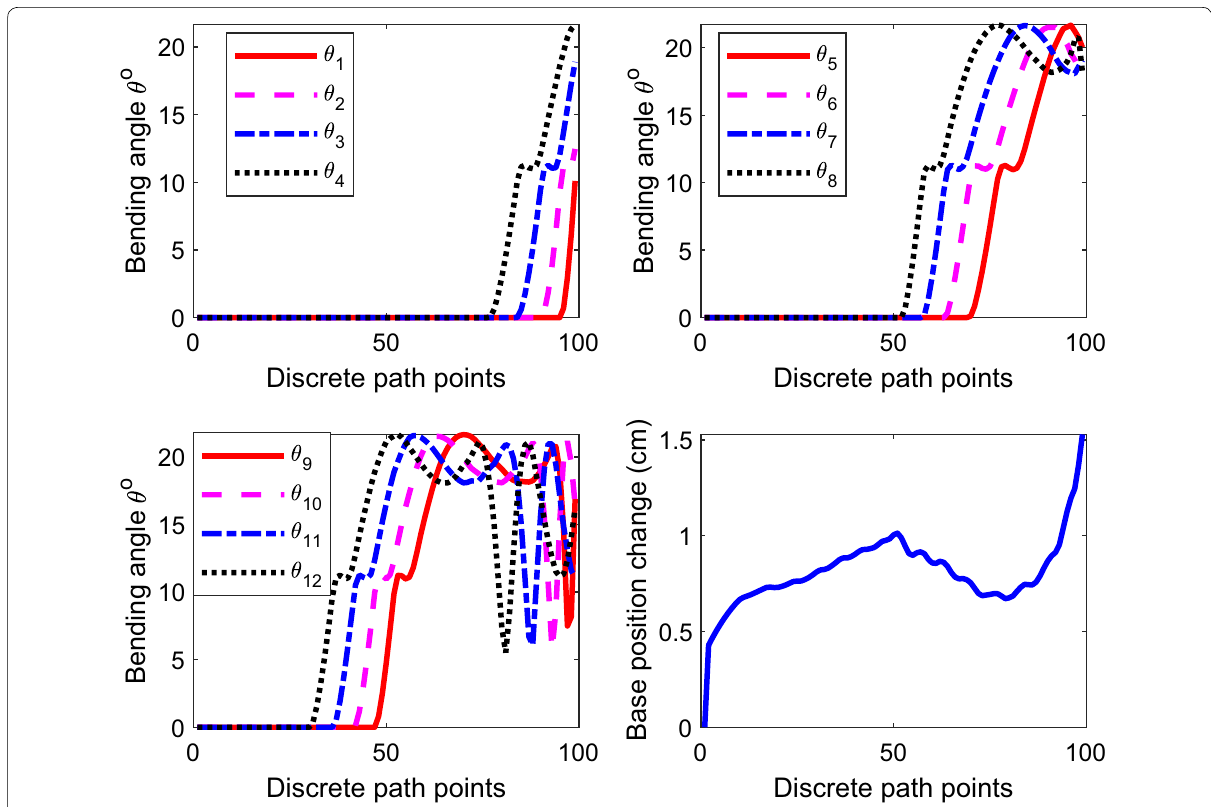
Figure 14 Bending angles and base position